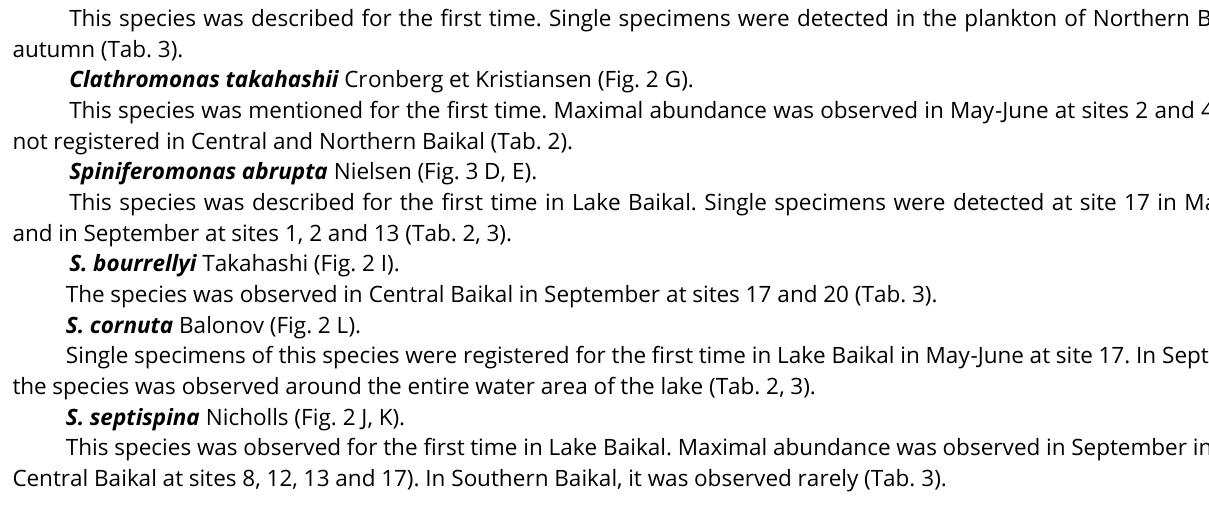
Table 3. List of species and intra-specific taxa of silica-scaled chrysophytes in Lake Baikal observed in September. Site numbers correspond to sites in Fig. 1. Abundance was estimated according to the following scale: